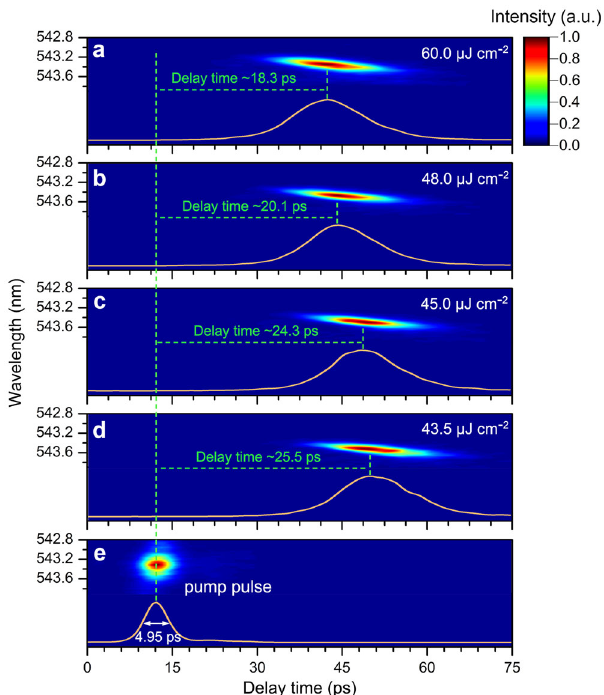
Fig. 3 Excitation-intensity-dependent time-resolved photoluminescence.